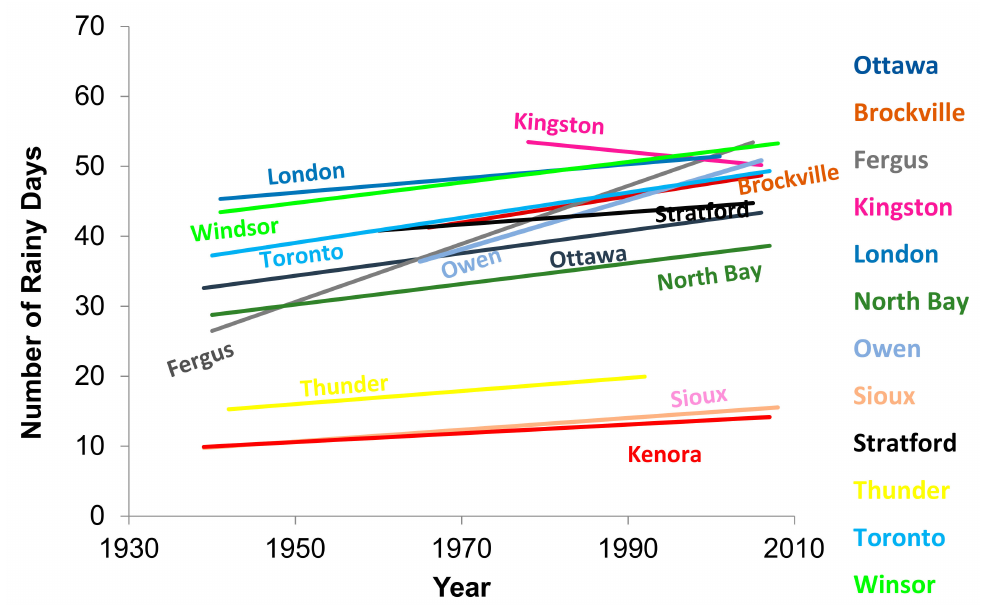
Figure 7. Annual variation in number of rainy days during winter across